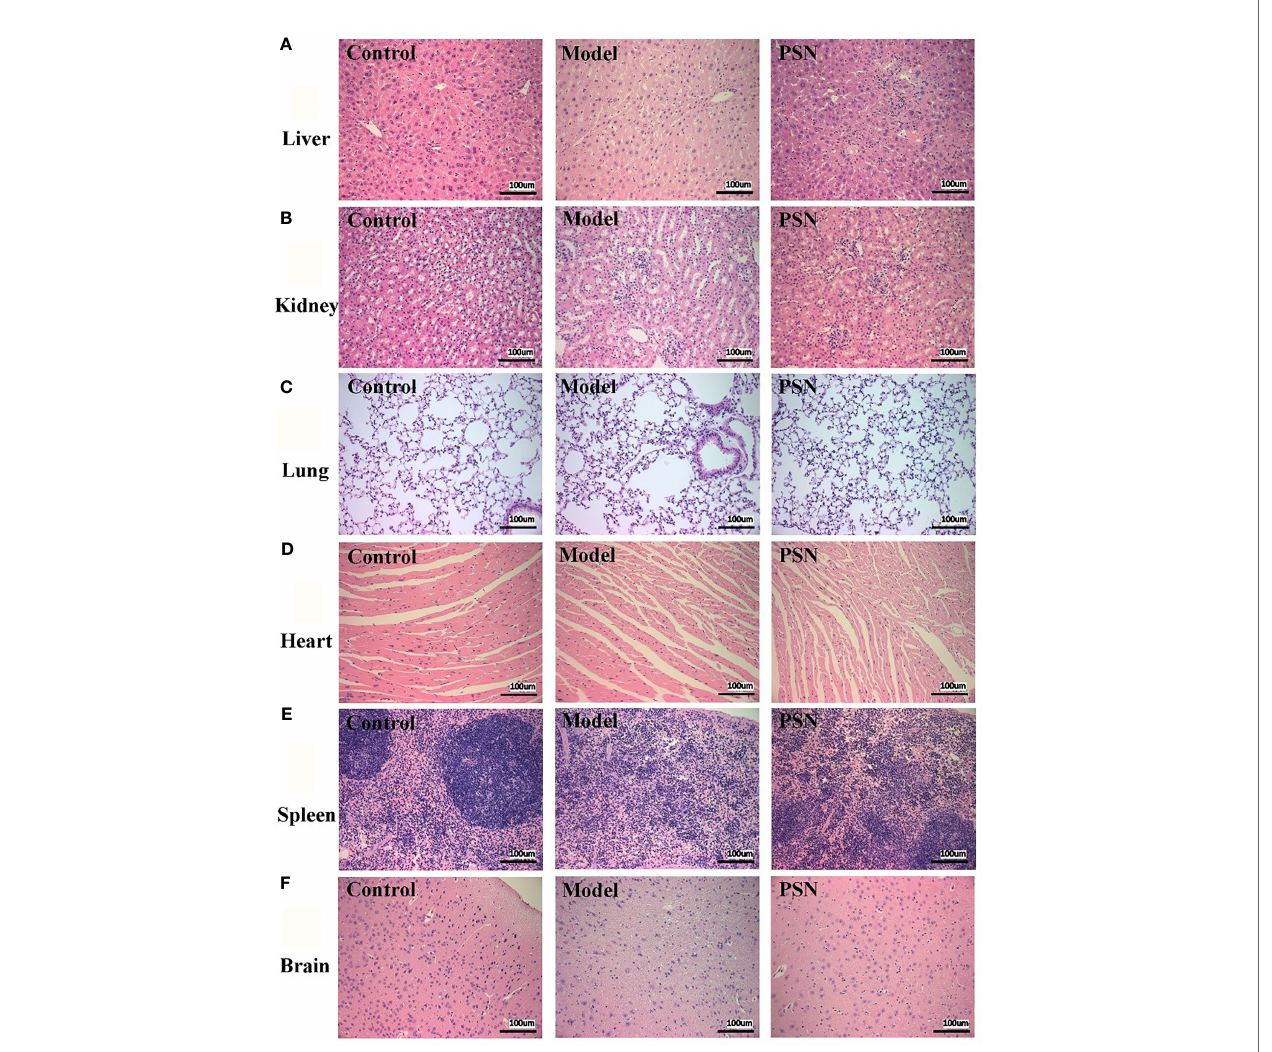
FIGURE 8 | HE staining of mice's tissue sections in control, HBV model, and PSN groups (×200). (A – F) Liver, kidney, lung, heart, spleen, and brain tissue in